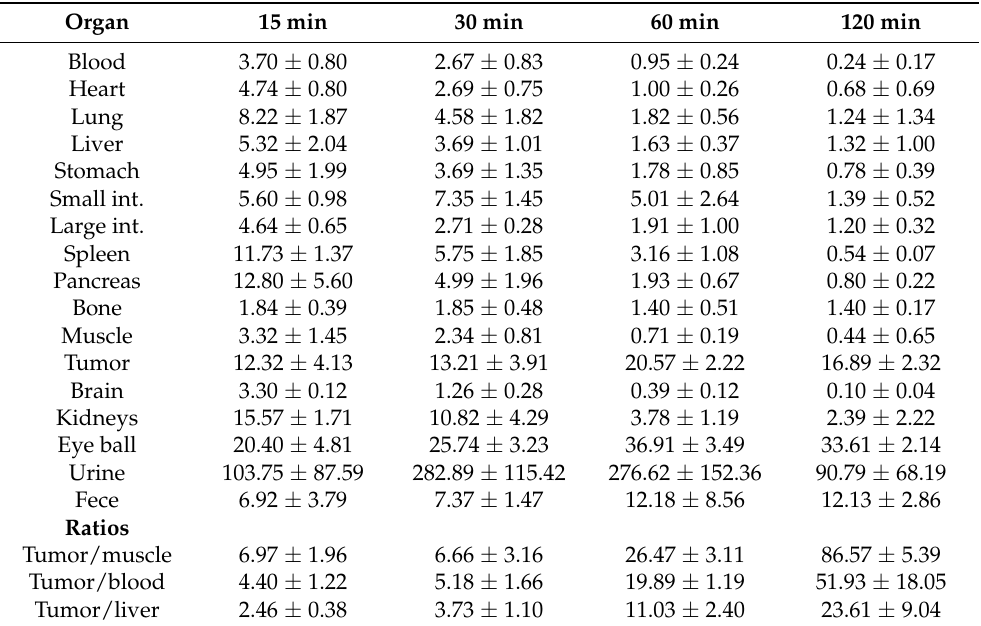
Table 1. Radioactivity distribution of 18 F-FPABZA in B16F10 melanoma-bearing C57BL/6